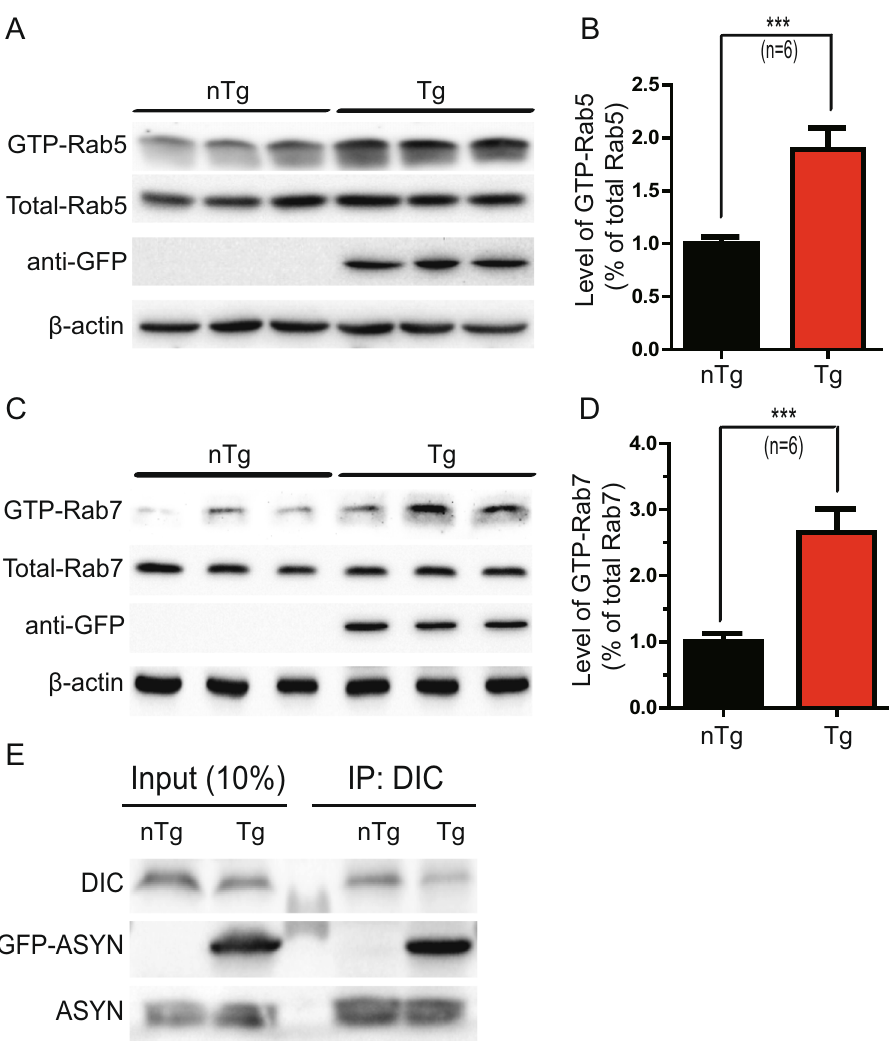
Figure 3. Increased level of GTP-bound Rab5 and Rab7 was detected in Line 78 E18 brain samples. Brain lysates were incubated with GTP-agarose beads to pull down activated GTP-bound Rab5 ( A ) as described in Materials and Methods. The levels of GTP-Rab5 in these samples were quantitated and normalized against internal control. Samples from Line 78 mice show an 89% increase over non transgenic controls ( B ). Similarly, activated Rab7 was pulled down ( C ) and a significant increase of GTP-Rab7 is seen in PDGF- β -ASYN- GFP mice as compared to non-transgenic controls ( D ). For B and D, results are from 6 animals per group. *** p < 0.01. Mouse brain homogenates were immunoprecipitated with an antibody recognizing dynein intermediate chain (DIC). Immunoprecipitates were analyzed by SDS-PAGE/immunoblotting with antibodies as indicated ( E ). At least three independent experiments were performed for all the studies presented.